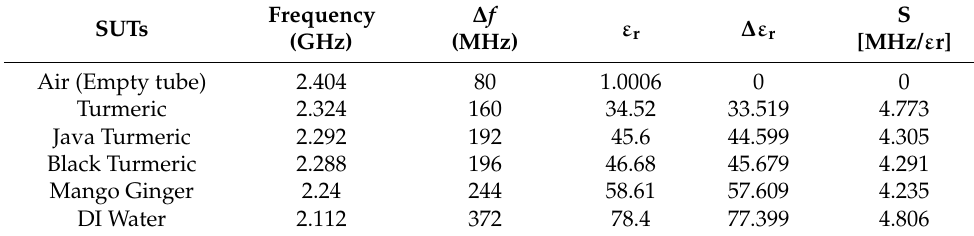
Table 10. Sensitivity of the various SUTs.